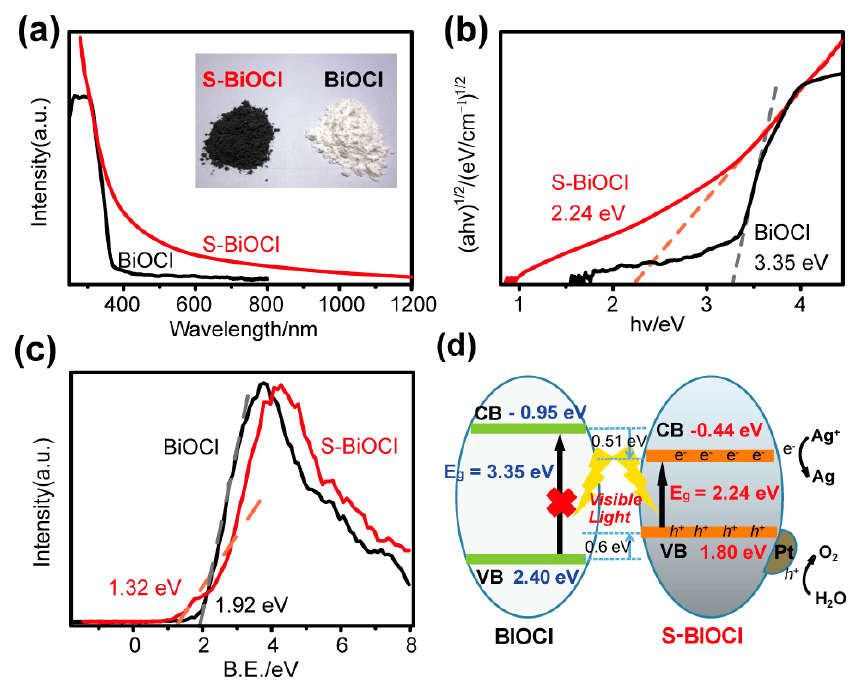
Figure 4. ( a ) UV–vis–NIR absorption spectra (inset is the optical image), ( b ) band gap fitted values by Kubelka–Munk function, ( c ) valence band XPS spectra, and ( d ) the illustration of band structures of commercial BiOCl and S-BiOCl.